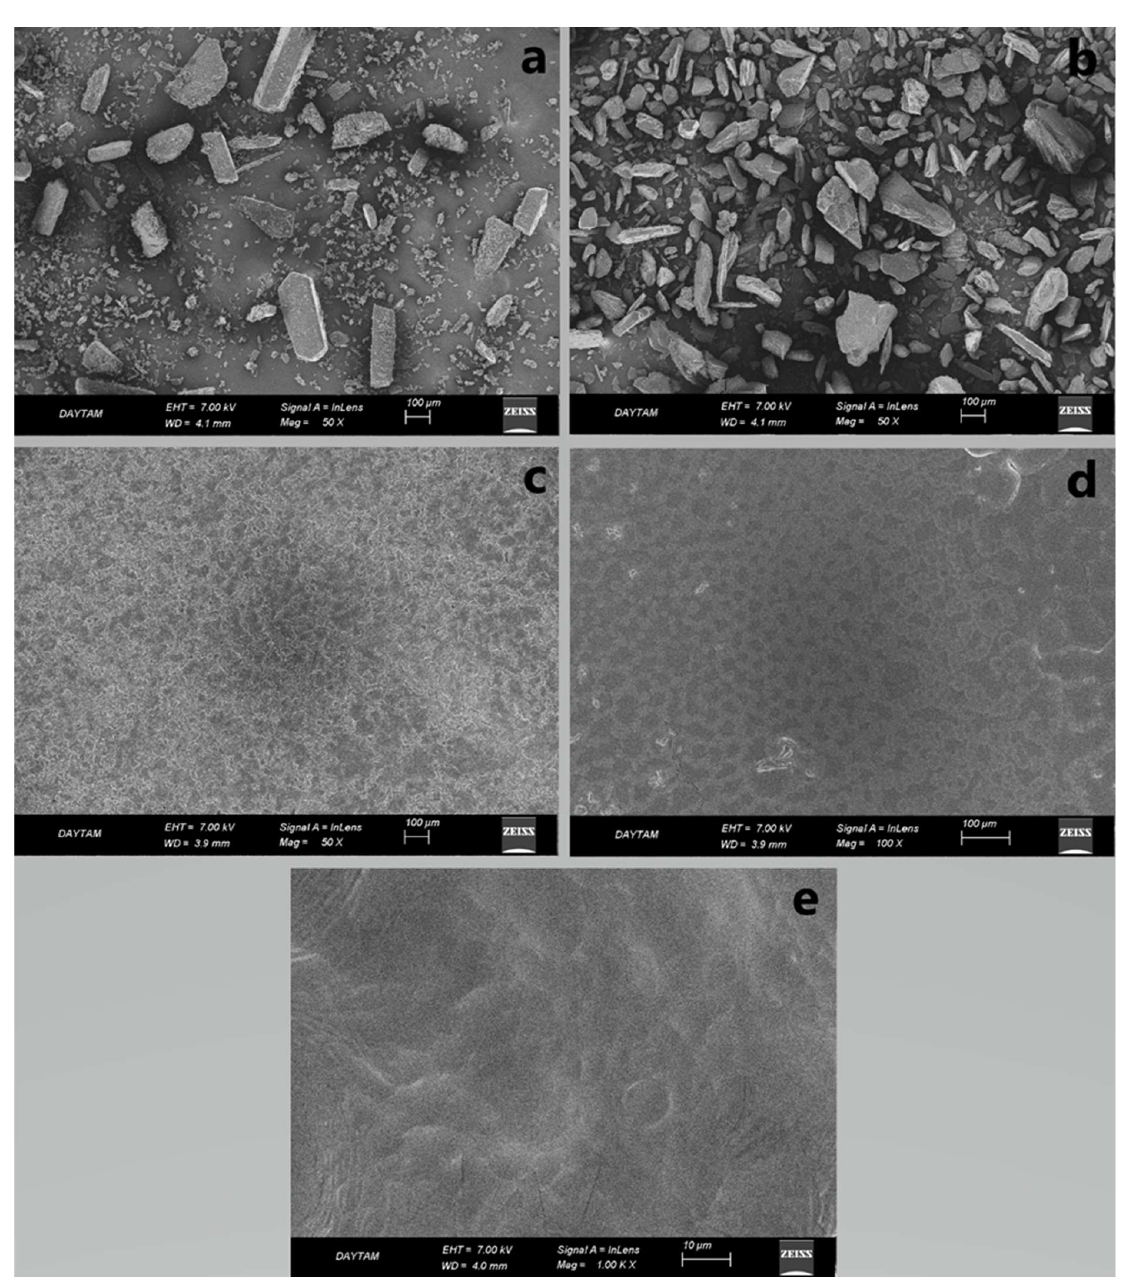
Figure 8. SEM images of pure drugs and selected formulations ( a ) PG, ( b ) MC, ( c ) F5, ( d ) F8, and ( e ) F13